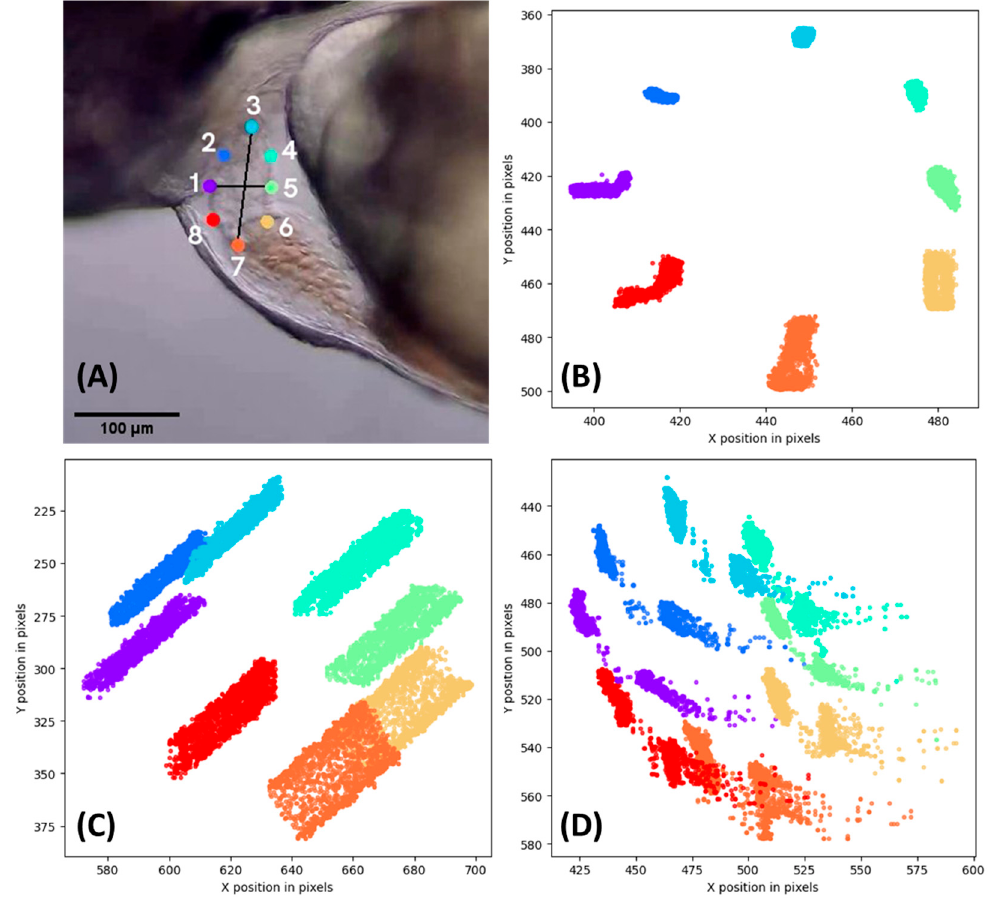
Figure 3. The representative image plots of the ventricle chamber labeled by DLC. ( A ) Eight different circle points label the ventricle of zebrafish larvae. ( B ) Plot created from normal placement without interference. ( C ) Plot created from a microscope slide that was moving slightly. ( D ) Plot created from the zebrafish heart that suddenly moved.